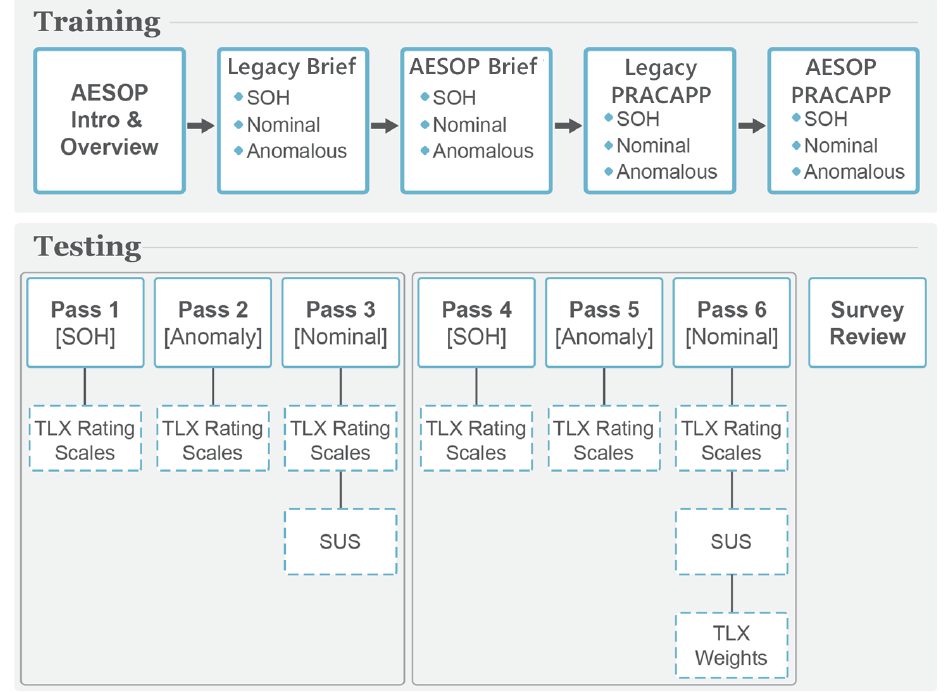
Figure 3. Text Procedure for Participants.